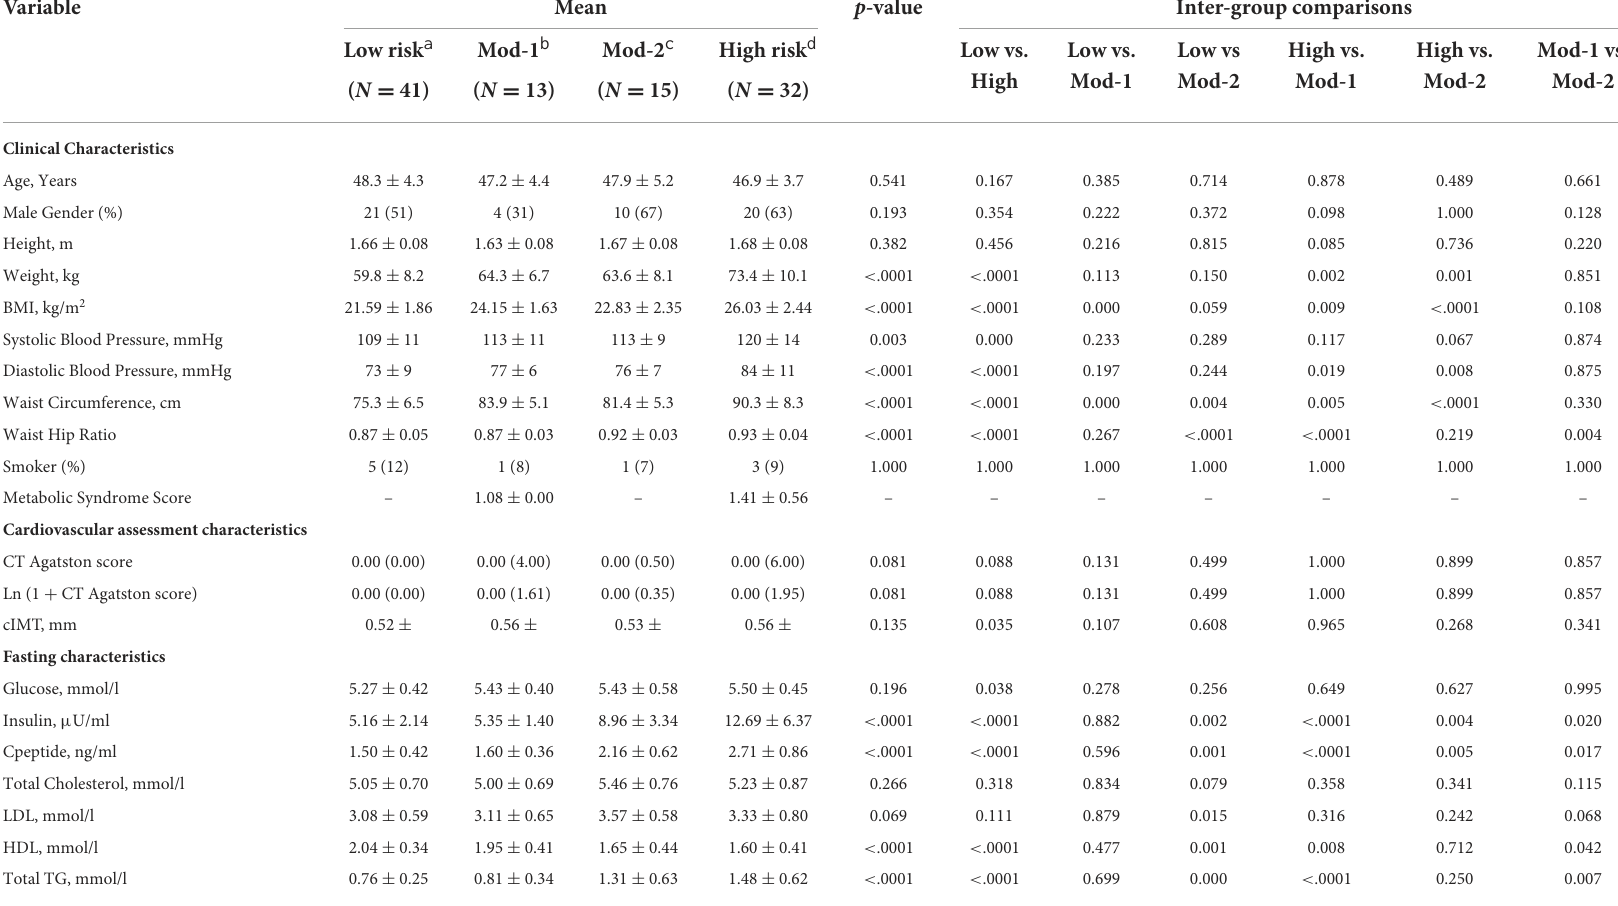
TABLE 1 Baseline characteristics of groups with and without concurrence of metabolic syndrome criteria (MetS) and predicted insulin sensitivity index (ISI-cal). Variable Mean p -value Inter-group comparisons Low risk a Mod-1 b Mod-2 c High risk d Low vs. Low vs. High vs. High High